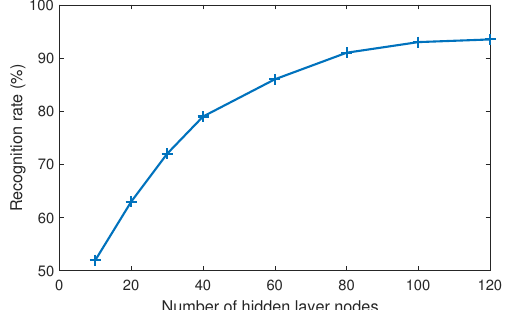
Figure 13. Recognition rate of extreme learning machine (ELM) with different number of hidden layer nodes.